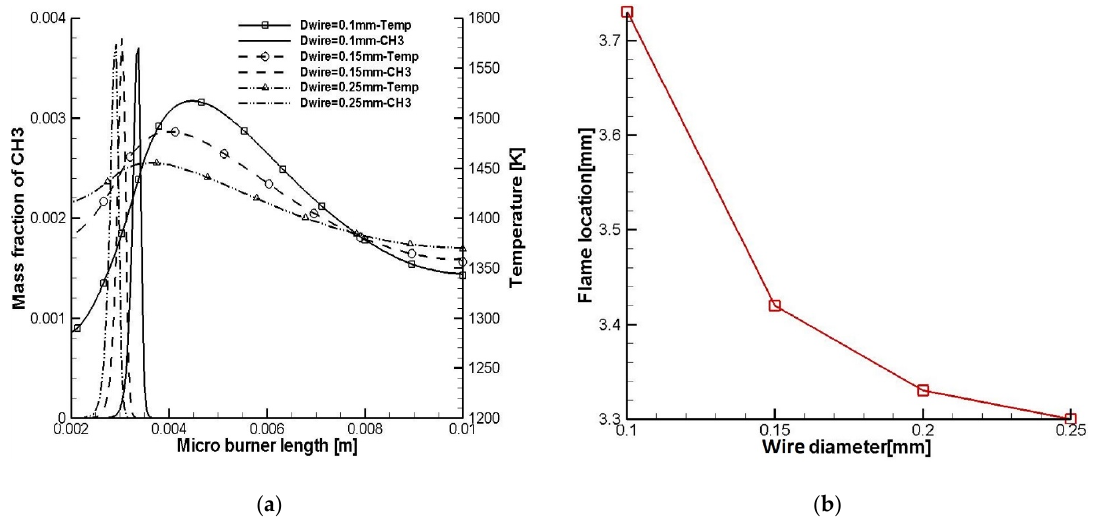
Figure 3. Contours of OH mass fraction show how the flame location in the micro-burner/combustor is affected by variations in the wire diameter.